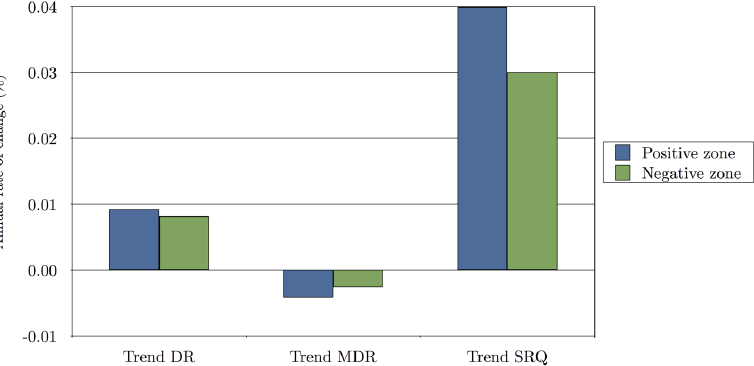
Fig 2. The annual change in developmental rates (DR), mortality rates of development (MRD), and survival rates of questing stages (SRQ) of H. marginatum in the period 1901 – 2009. Data were calculated and disaggregated for the areas where the tick is known to have permanent populations (positive zone: PZ) or where the tick has not yet been collected (negative zone: